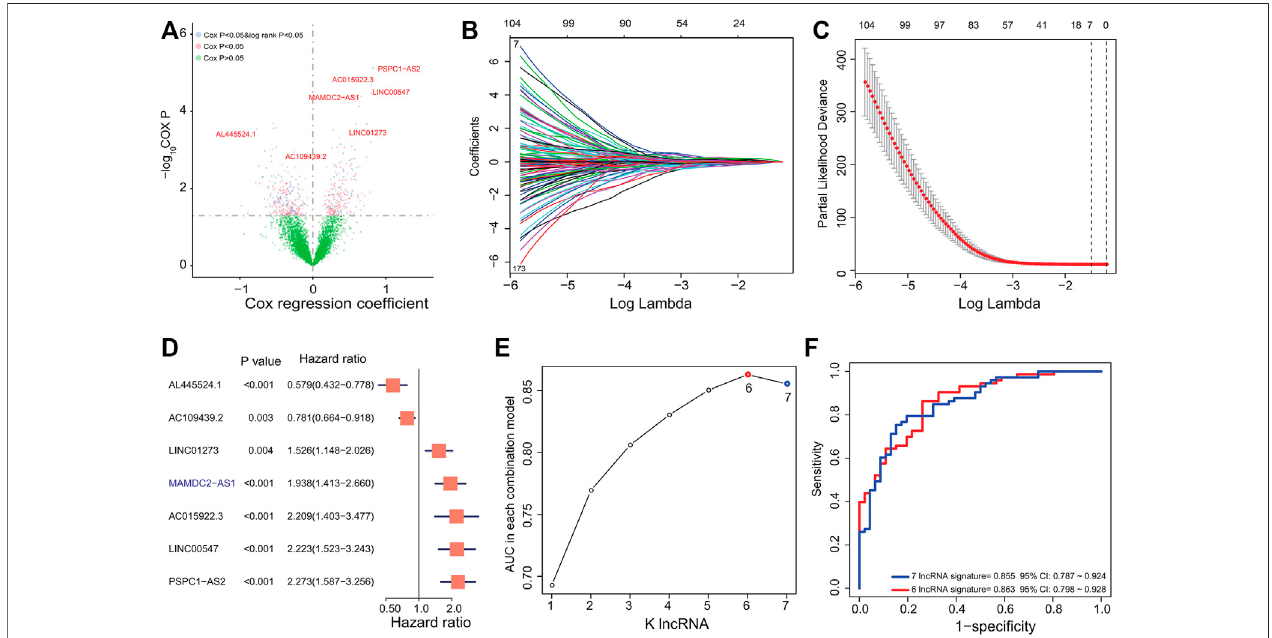
FIGURE1| DerivationandselectionofthelncRNAsignatureinthetrainingdataset. (A) UnivariateCoxregressionandKManalysisidenti fi ed209prognosis-related lncRNAs in the training dataset. (B) LASSO coef fi cient pro fi les for the 209-lncRNA set in the training dataset. (C) Cross-validation error rates for selecting the tuning parameters. (D) Hazard ratio of the selected lncRNAs by LASSO. (E) The AUC values of 127 multi-lncRNA signatures were calculated by ROC curve analysis. (F) ROC curve analysis for the 127 combinations and selected six-lncRNA signature in the training dataset.